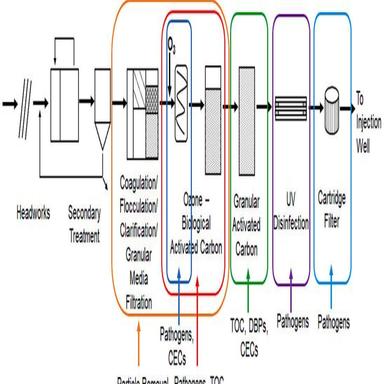
The multi-barrier Advanced Water Treatment (AWT) system for potable reuse applications.